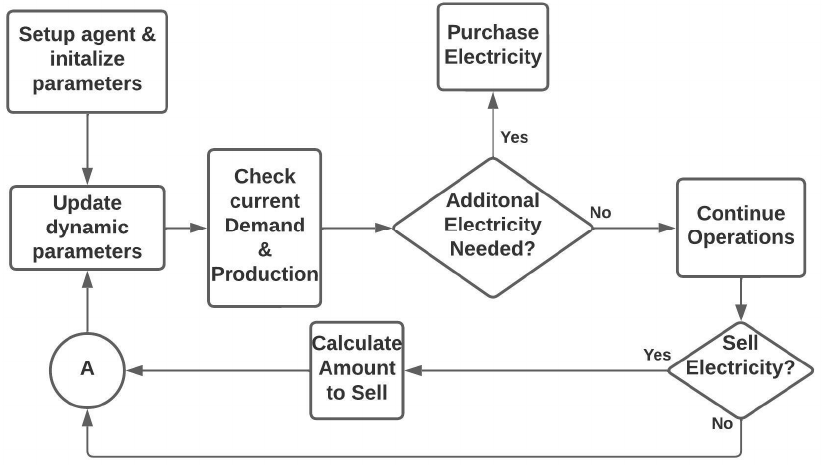
Figure 5. Microgrid agent decision-making process.